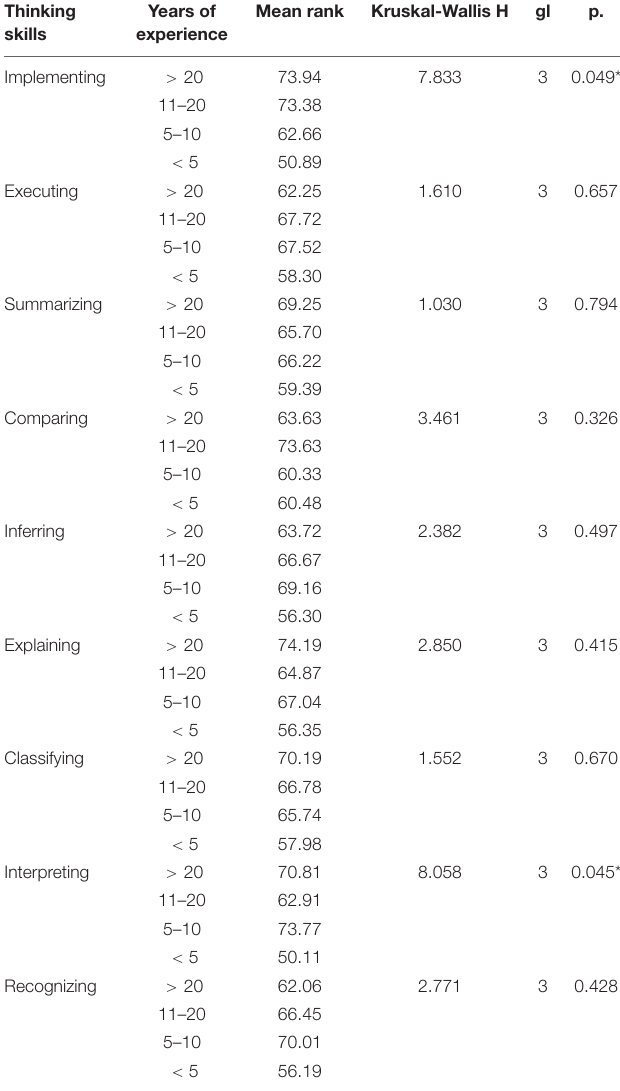
TABLE 6 | Non-parametric results of the practice of cognitive processes according to teachers’ years of experience. Thinking Years of Mean skills experience